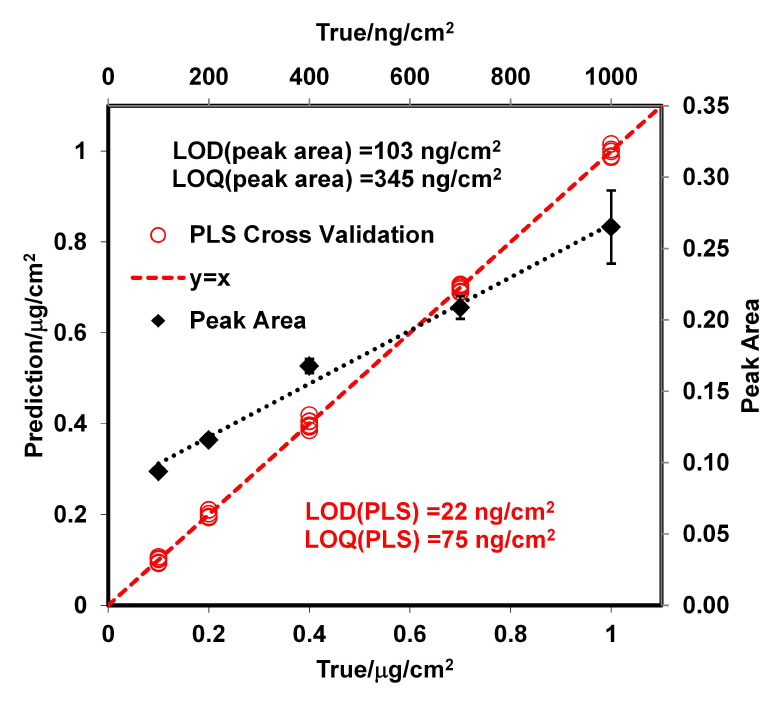
Figure 3. Calibration curves for RDX on SS by classical least squares (CLS) and PLS